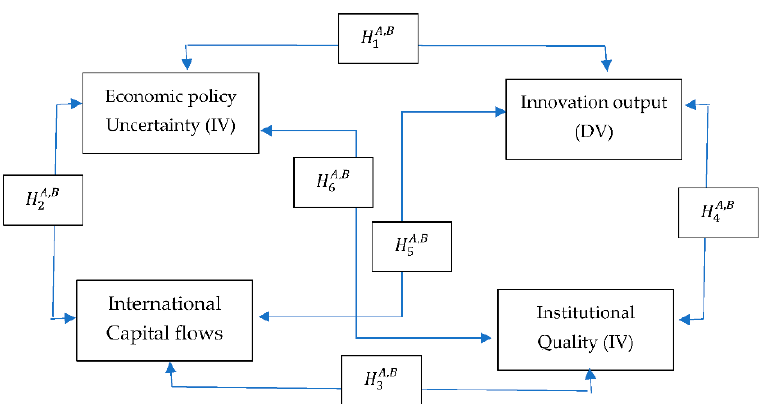
Figure 1. Possible directional causalities. H A , B : Economic policy uncertainty does not cause innovation output and vise-versa; H A , B : Economic policy uncertainty does not cause FDI and vise-versa; H A , B : Institutional quality does not cause FDI and vise-versa; H A , B : Institutional quality does not cause innovation output and vise-versa; H A , B : FDI does not cause innovation output and vise-versa; H A , B : Economic policy uncertainty does not cause institutional quality and vise-versa.